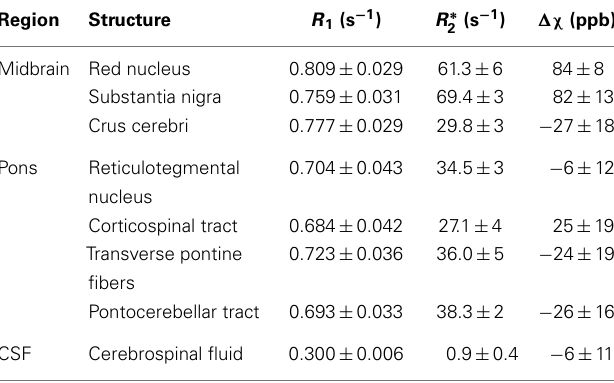
Table 1 | Mean values of longitudinal relaxation rate ( R 1 ), effective transverse relaxation rate ( R ∗ 2 ), and volume magnetic susceptibility difference ( ∆χ ) with respect to normal appearing white matter over six subjects and both brain hemispheres for selected anatomical regions